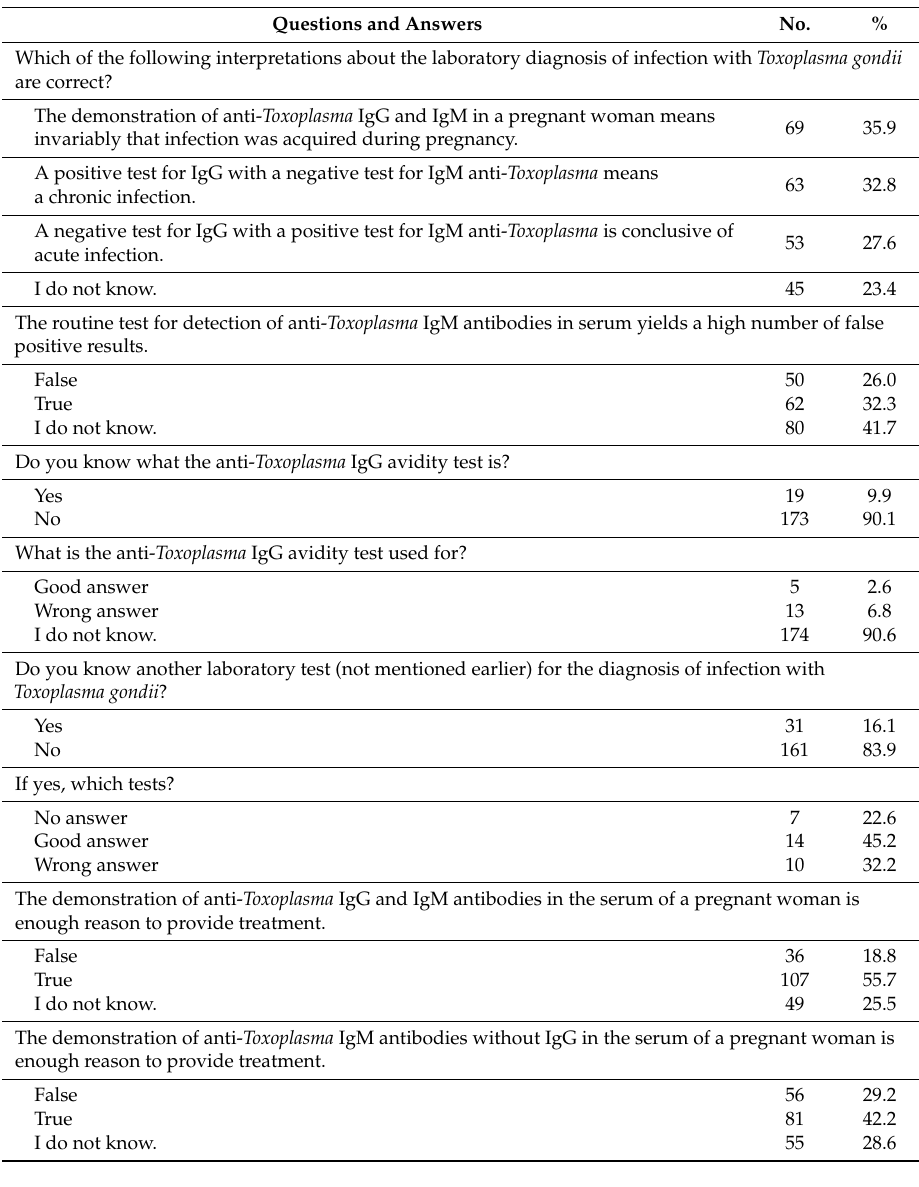
Table 4. Knowledge of the epidemiology of